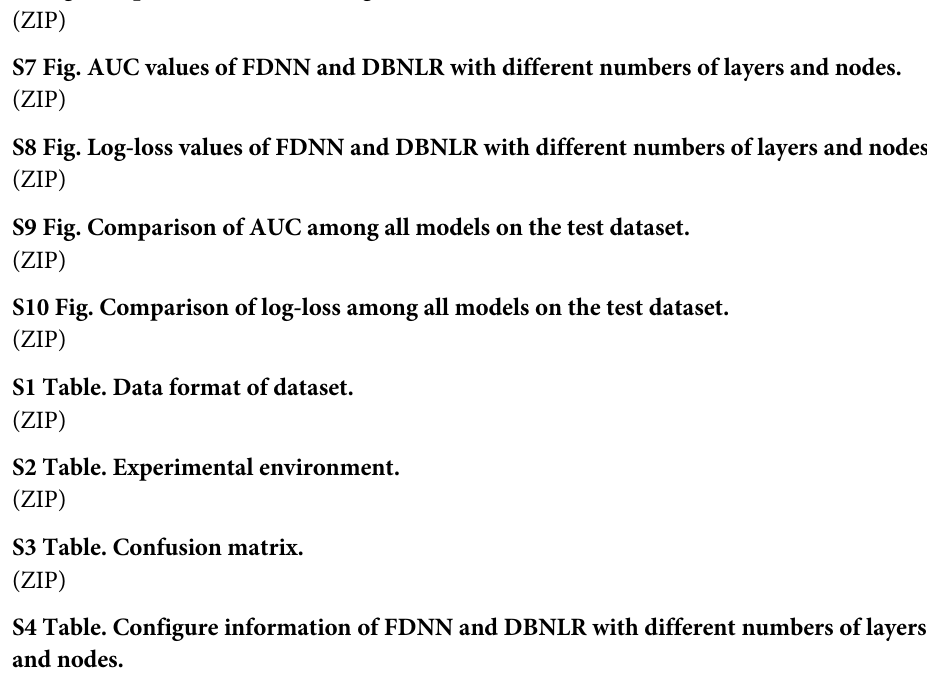
S6 Fig. The process of constructing FDNN. (ZIP) S7 Fig. AUC values of FDNN and DBNLR with different numbers of layers and nodes. (ZIP) S8 Fig. Log-loss values of FDNN and DBNLR with different numbers of layers and nodes. (ZIP) S9 Fig. Comparison of AUC among all models on the test dataset. (ZIP) S10 Fig. Comparison of log-loss among all models on the test dataset. (ZIP) S1 Table. Data format of dataset. (ZIP) S2 Table. Experimental environment. (ZIP) S3 Table. Confusion matrix. (ZIP) S4 Table. Configure information of FDNN and DBNLR with different numbers of layers and nodes.